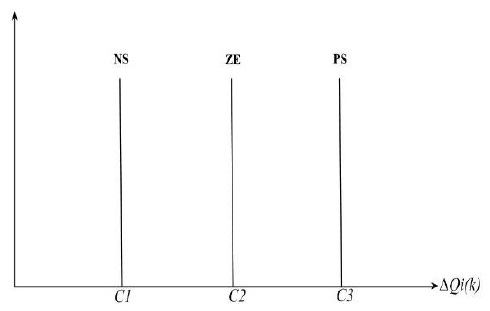
Figure 5. The fuzzifier membership function of the type-II controller ( e i ( k ) and ∆ e i ( k ) ).